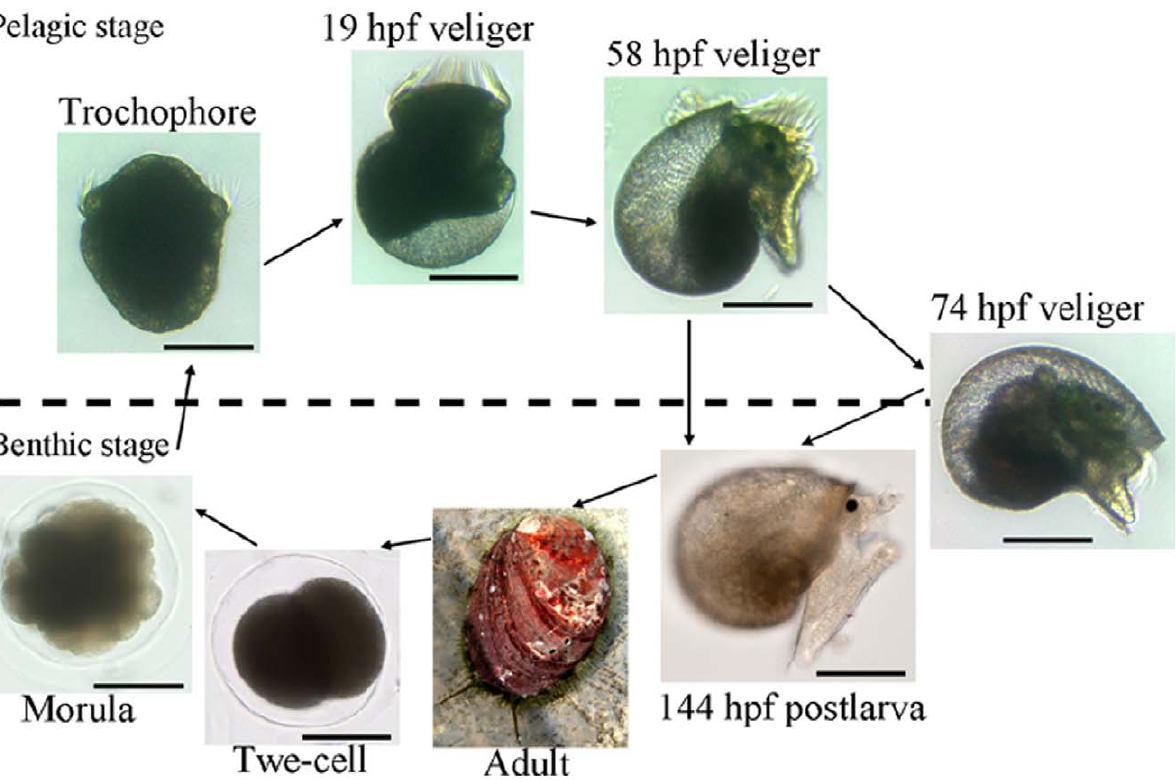
Figure 1. Developmental stages of the abalone H.diversicolor that were sampled for transcriptomic analyses. The stages include two- cell (2CELL, 0.5 hpf), morula (MORU, 3.2 hpf), trochophore (TROC, 9.5 hpf), 19 hpf veliger (19VEL), 58 hpf veliger (58VEL), late competent veliger larvae (74VEL, 74 hpf), postlarvae after 3 days settlement (144PL, 144 hpf) and adult intestinal tissue (INTE, 18 months). Scale bar=100 m m.